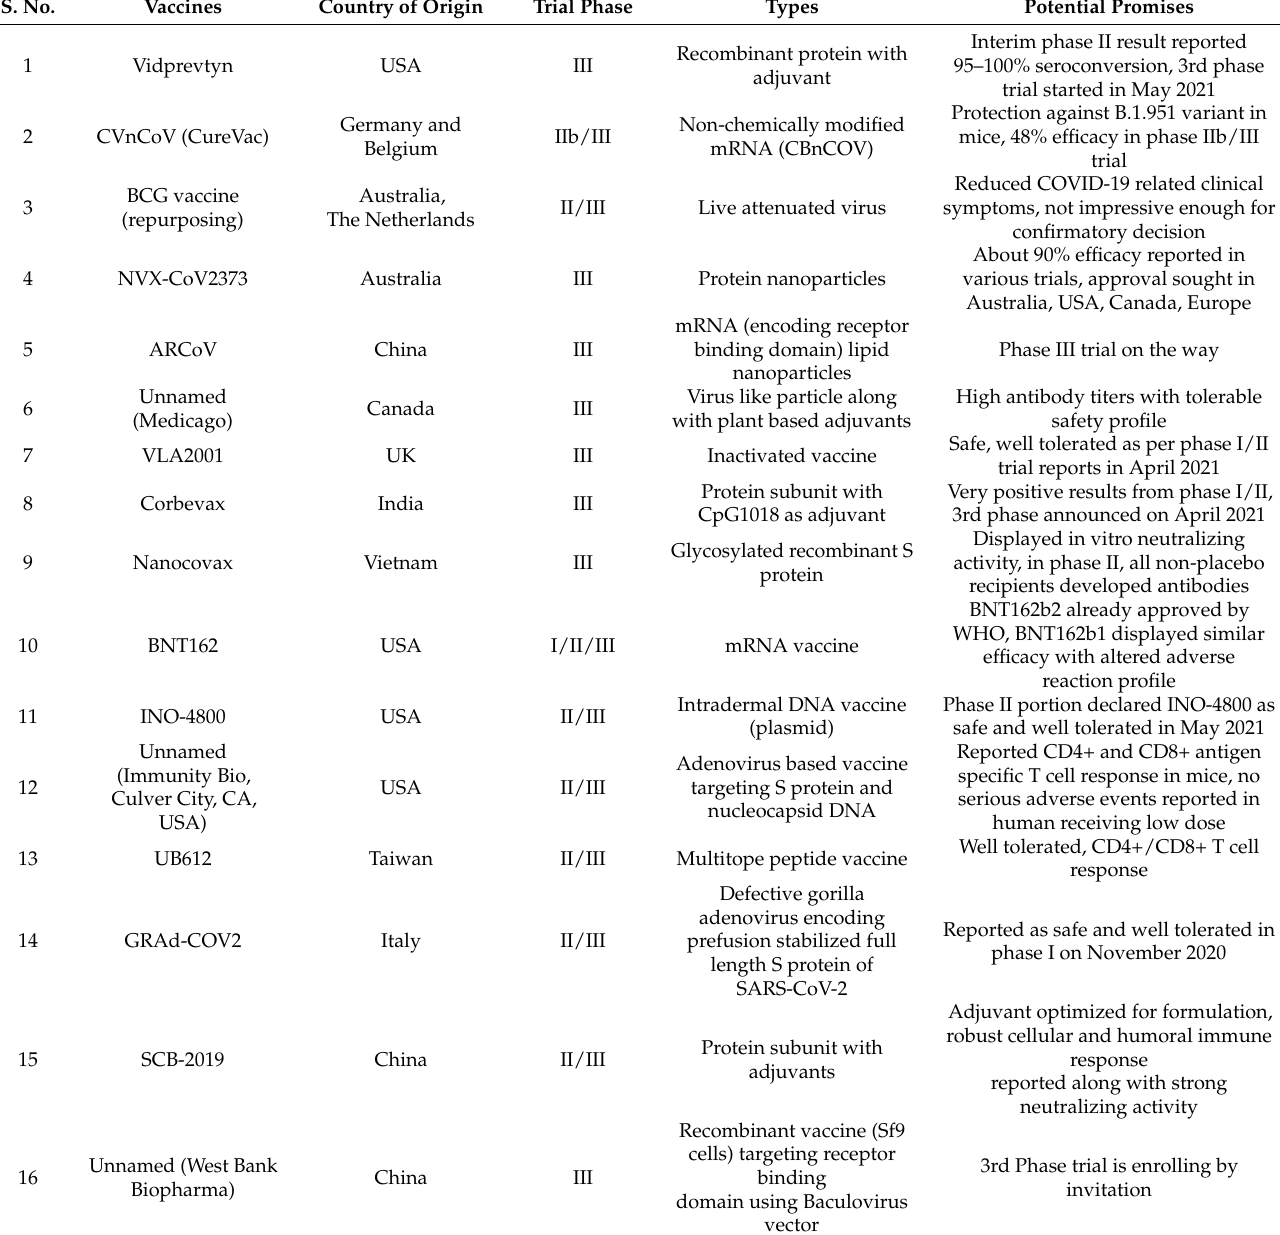
of the vaccine candidates. Table 3 enlists the current frontrunners in clinical trials likely to get approval in the near future. Table 3. Forerunners in clinical trials: possible candidates for